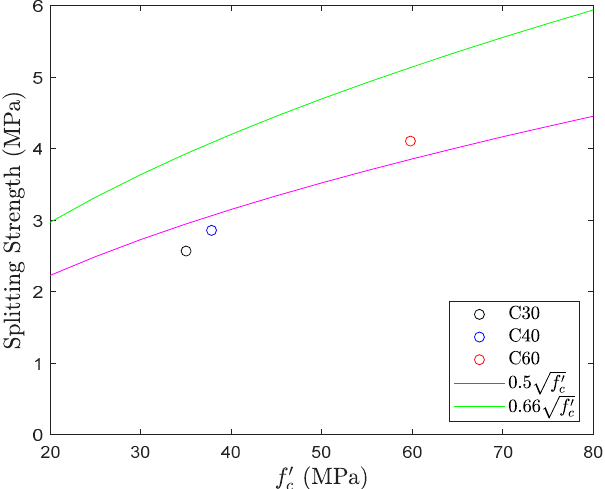
Figure 15. Tensile strength obtained from splitting test.